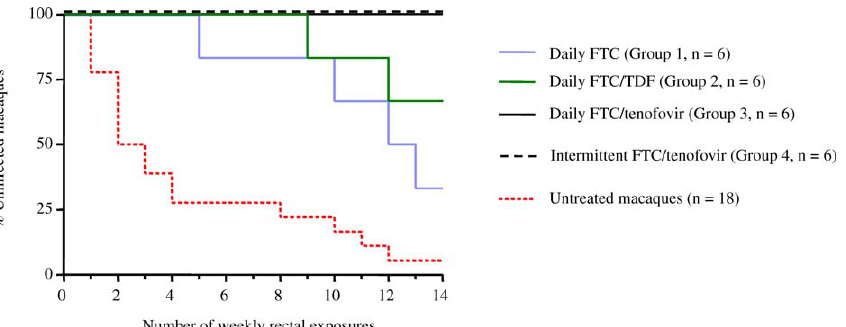
Figure 2. Protection against Repeated Rectal Virus Exposures by Daily or Intermittent PrEP Each survival curve represents the cumulative proportion of uninfected macaques as a function of the number of weekly rectal exposures. Protected animals in groups 1–4 remained negative after a mean washout out of 27 wk (range, 17–60